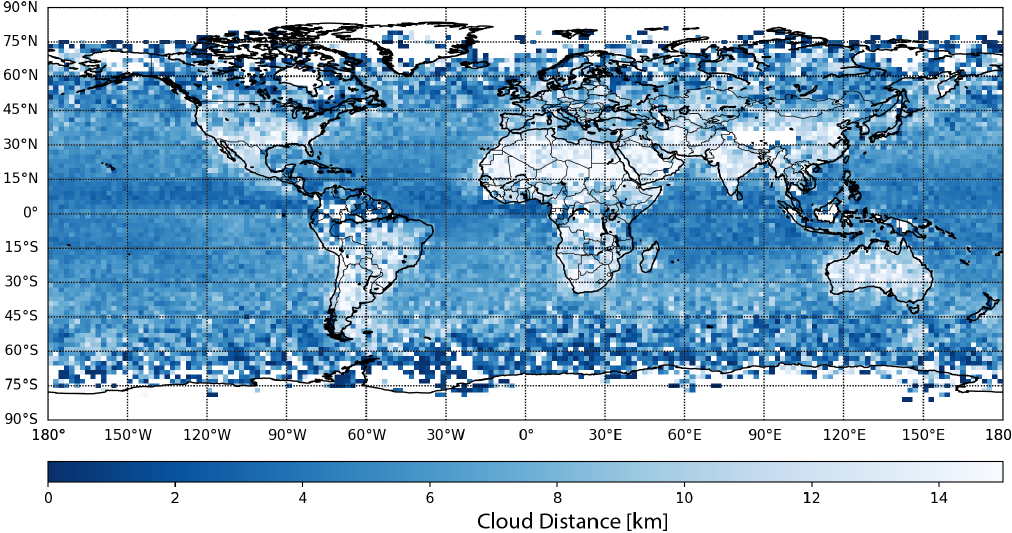
Figure 10. Nearest-cloud distance derived from MODIS. Nearest-cloud distances are averaged over 2 ◦ × 2 ◦ for all matched soundings (2014 to 2019; QF = 0 and QF = 1). Darker blues indicate closer clouds; “no data” is shown in